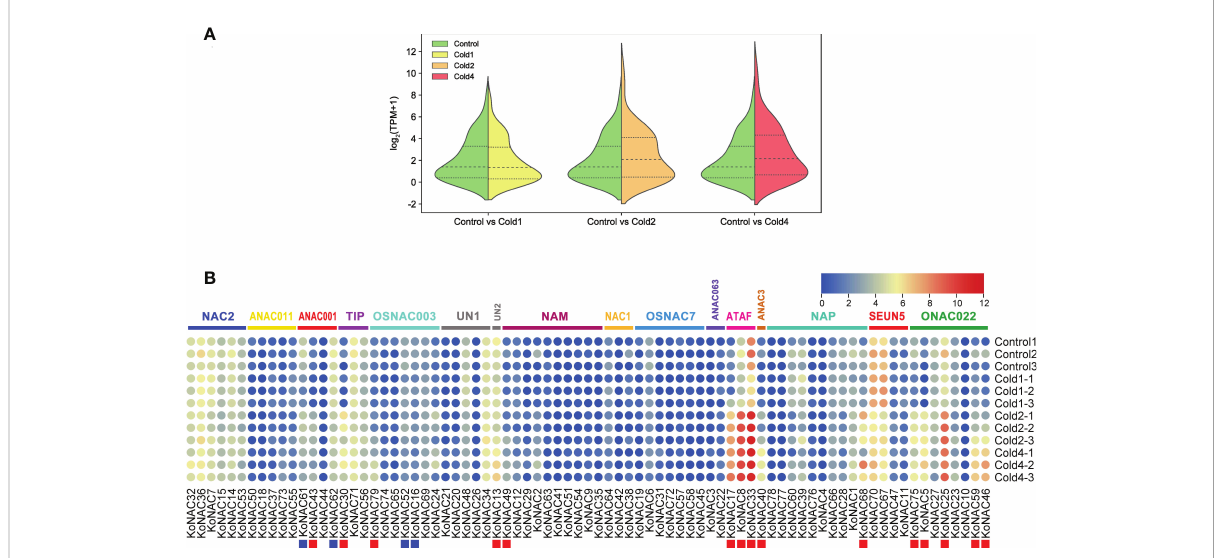
FIGURE 9 Expression of KoNAC genes in Kandelia obovata . (A) Bean plot of all KoNACs before and after 4°C chilling stress. (B) The transcript levels of KoNAC genes in response to cold stress were investigated based on publicly available transcriptomic data. Ten-month-old seedlings of K. obovata were treated, and the leaves were collected for transcriptome analysis. Cold1, the fi rst time cold treatment, 2/5°C (light/day) for 4 d, then recovery at 22/27°C (light/day) for 15 d; Cold2, the second time cold treatment, continue 2/5°C (light/day) for 4 d, then recovery at 22/ 27°C (light/day) for 15 d; Cold3, the third time treatment, continue 2/5°C (light/day) for 4 d, then recovery at 22/27°C (light/day) for 15 d; Cold4, the fourth time treatment, continue 2/5°C (light/day) for 4 d. The red and blue squares indicate signi fi cantly enhanced and repressed expression under chilling stress, respectively ( p < 0.05).